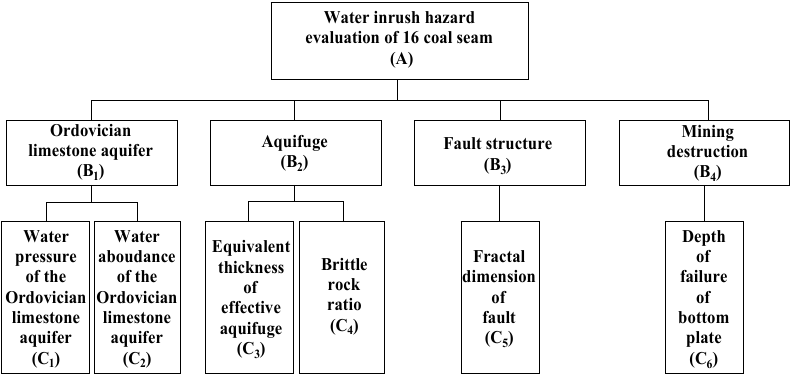
Figure 5. The proposed water inrush of the coal seam floor safety evaluation index.